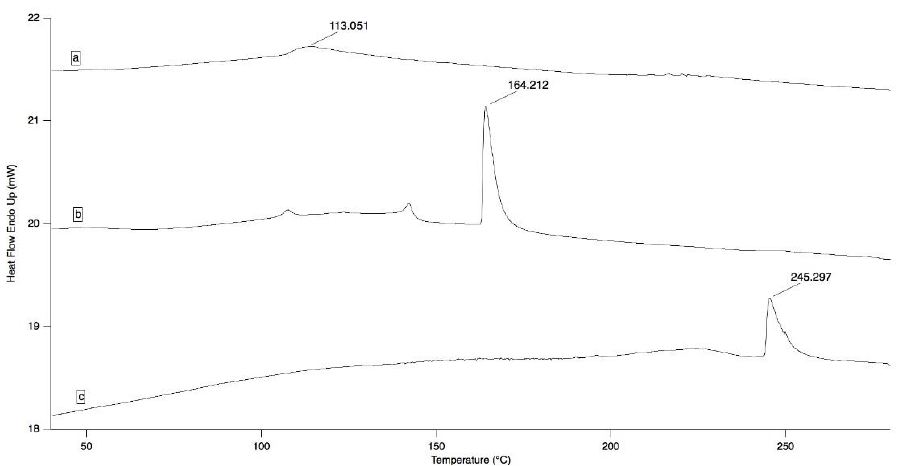
Figure 1. DSC thermograms of OLE (a), HP- β -CD (b), and OLE/HP- β -CD co-precipitate (c), at a scanning rate of 5 °C/min.